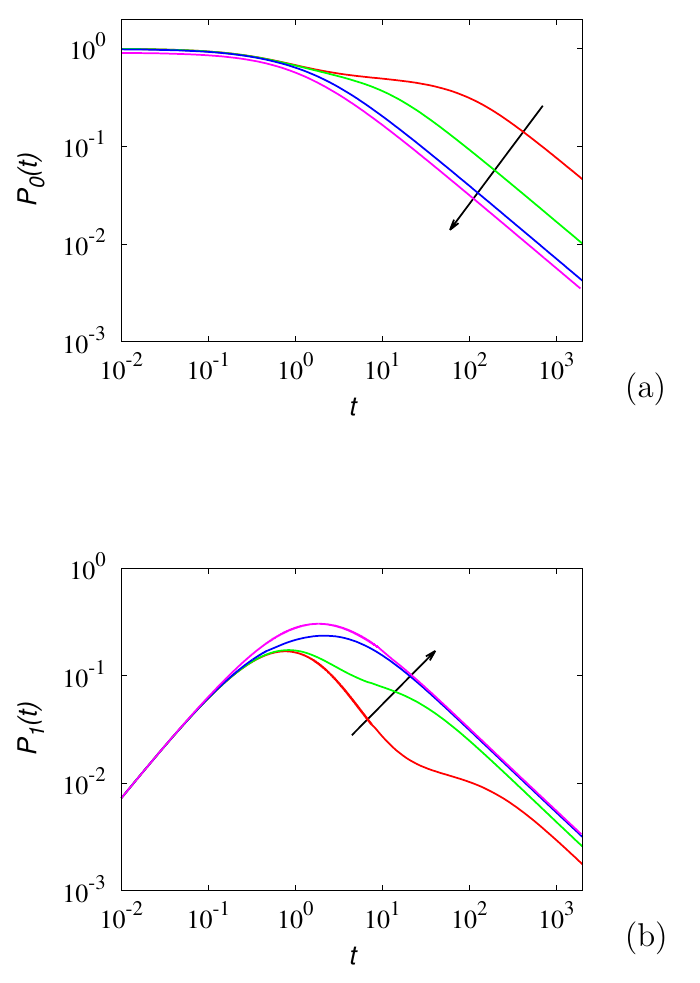
Figure 7. P 0 ( t ) ( a ) and P 1 ( t ) ( b ) vs. t for the ES process discussed in the main text with ξ = 1.5, = 0.5, for different values of µ . The arrows indicate increasing values of µ = 0.01, 0.1, 1, π + 0